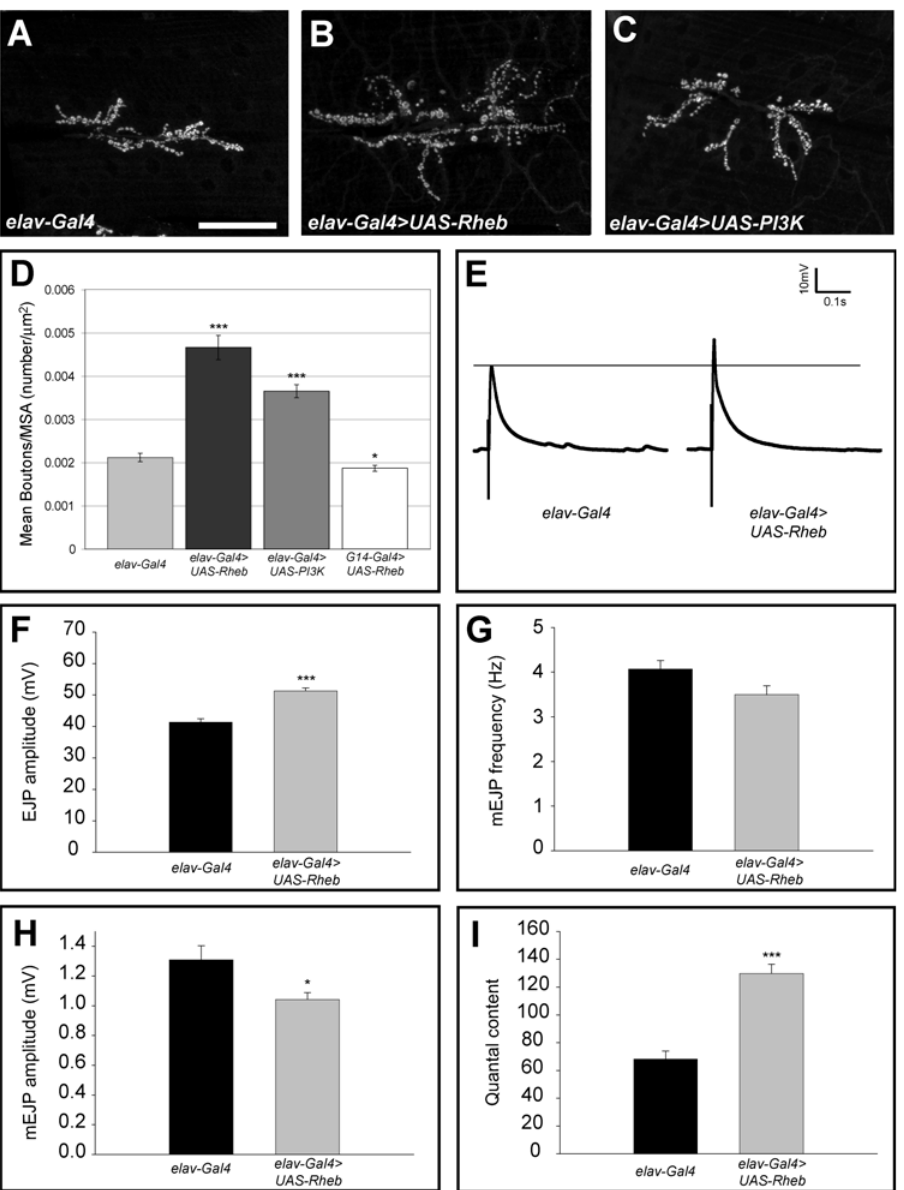
Figure 1. Activation of the Tor pathway produces synaptic growth and enhanced physiological function. The morphology of the third instar larval NMJ was visualized with the presynaptic marker anti-cysteine string protein (CSP) and confocal microscopy. Images shown are stacks of 20 or more optical sections. Neuronal ( elav-Gal4 ) expression of either Rheb (B) or Pi3K (C) increased the size of the synapse compared to control animals bearing the elav-Gal4 transgene alone (A). Numbers of synaptic boutons/muscle area are quantified in D. Expression of either UAS-Rheb (n=41) or UAS-Pi3K (n=41) produced a significant increase in the number of boutons/muscle area compared to controls (n=44), while expression of UAS-Rheb in the muscle (driven by G14-Gal4 , n=18) produced a reduction. Neuron-specific expression of Rheb also produced electrophysiological changes at the NMJ, determined by intracellular recordings from abdominal muscle 6 in third instar larvae. The amplitude of the EJP was significantly increased in animals expressing UAS-Rheb (n=21) compared to controls with elav-Gal4 alone (n=12). Examples of EJP voltage traces are shown in E, and mean EJP values are quantified in F. Quantal content, a measure of the number of synaptic quanta released in a single firing of the motoneuron, was nearly doubled by neuron-directed expression of Rheb compared to controls (I). Mini-EJP amplitude was decreased in these animals (H), while mEJP frequency showed no significant change (G). In this and all subsequent figures, *** denotes p-values less than 0.00005 using a student t-test comparison with controls, ** denotes p-values less than 0.005, and * denotes p-values less than 0.05. The scale bar is 50 microns in panel A.